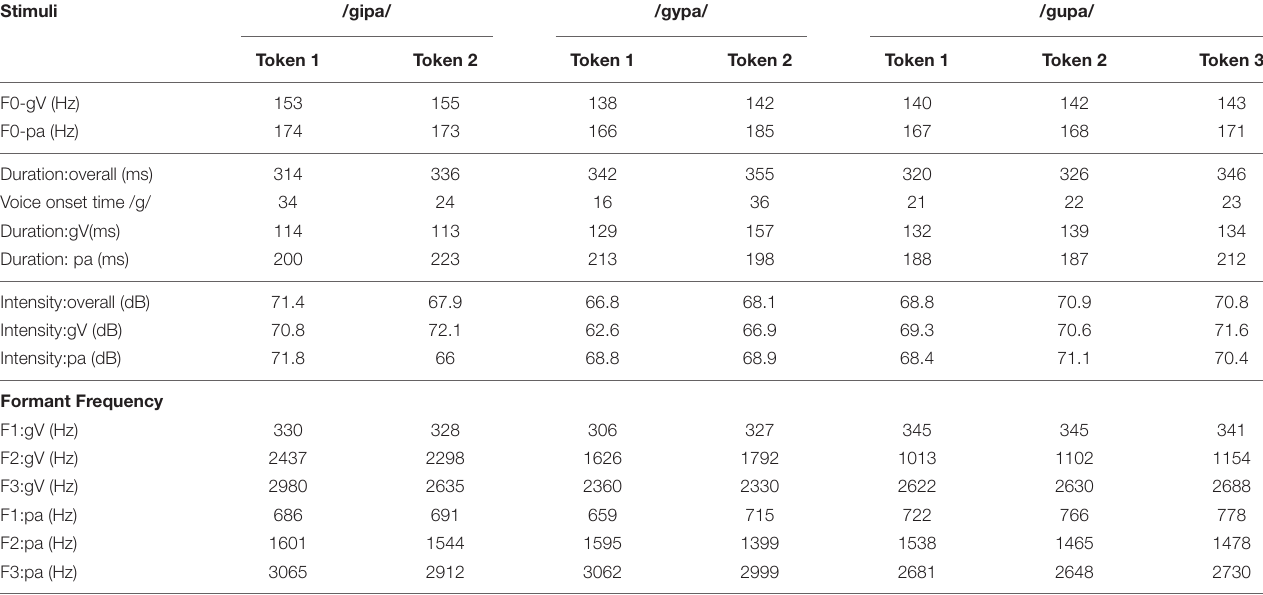
TABLE 1 | Characteristics of the experimental stimuli.